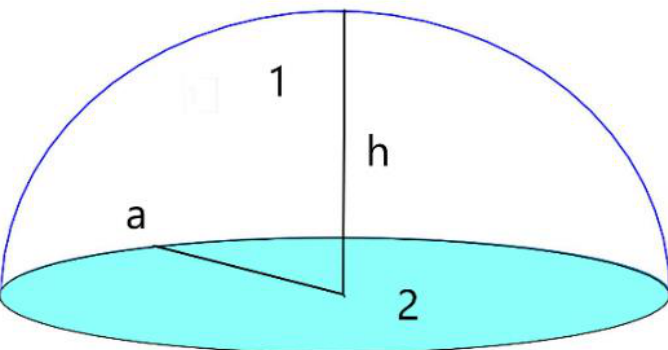
Figure 2. A spheric fragment (surf. 1) with vertical elevation h and sphere radius R, over a circular base (surf. 2) with radius a, different from R.